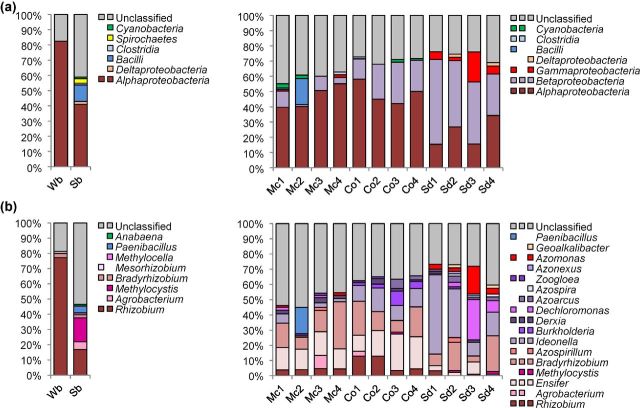
Taxonomic classification of NifH sequences in bulk soils and associated with the rhizosphere of medicinal plants obtained by 454 amplicon sequencing. Wb = desert soil, Sb = agricultural soil, Mc = M. chamomilla, Co = C. officinalis, Sd = S. distichum. NifH amino acid sequences were classified at class (a) and genus (b) level. From each medicinal plant, four independent replicate samples were investigated separately. PCR products of soil replicates were pooled to one composite sample per soil type. Clusters containing less than 1% of quality sequences were not designated. Multi-colored charts at the legend are shown for each soil or rhizosphere type correspondingly.